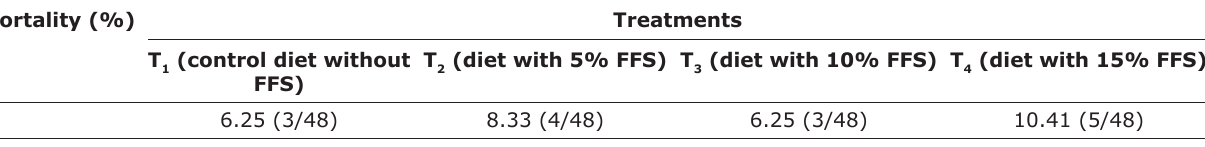
The figure in parenthesis represents number of birds dead/total number of birds. FFS=Fermented fish silage Table-2: Effect of feeding FFS on body weight gain, feed consumption and FCR of broiler Japanese quails at 1-5 weeks of age. Parameters/treatments Age in T (control diet 1 weeks without